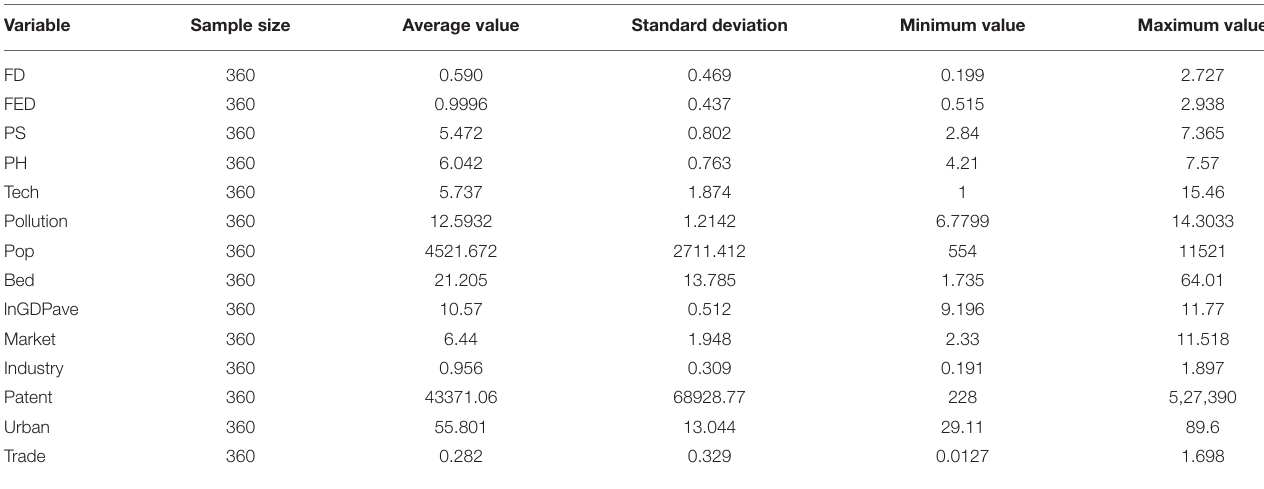
TABLE 2 | Descriptive